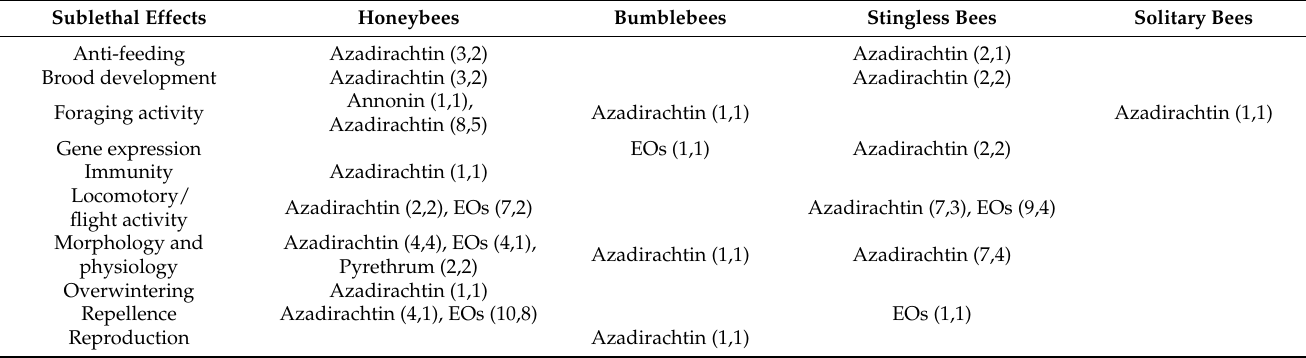
Table 3. Classes of sublethal effects caused by botanical biopesticides reported in the reviewed studies on different groups of Hymenoptera Apoidea. In parentheses the total number of studies and the number of studies showing a significant detrimental